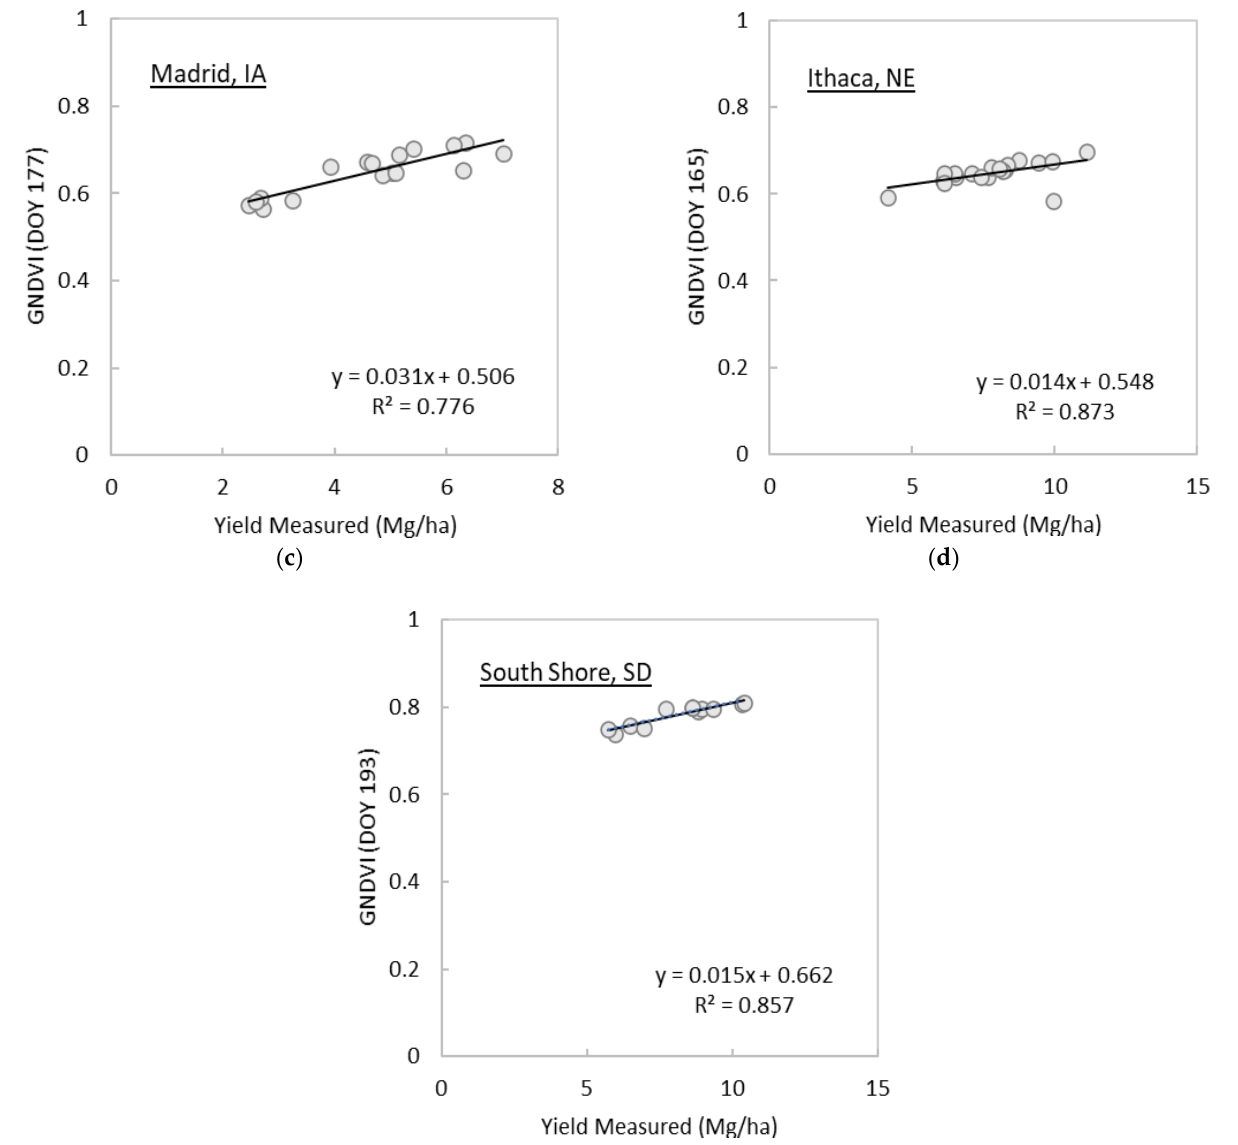
Figure 5. Scatter plots of perennial grass yield measured at harvest and the green normalized difference vegetation index (GNDVI) on the dates having the highest correlation with yields across the ( a ) Brighton, Illinois (IL); ( b ) Urbana, IL; ( c ) Madrid, Iowa (IA); ( d ) Ithaca, Nebraska (NE); and ( e ) South Shore, South Dakota (SD), sites.